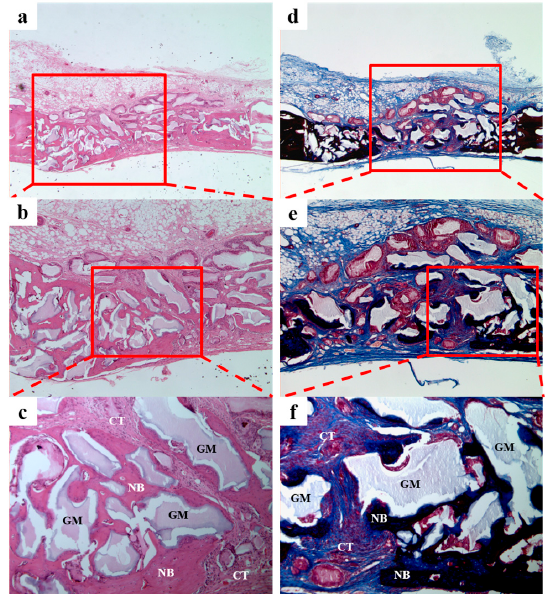
Figure 10. Histological sections of the BCP group at 4 weeks after surgery. A small amount of new bone formation and fibrous connective tissue were observed. NB: new bone; GM: grafted material; CT: connective tissue. Hematoxylin and eosin (H&E) stain results ( a – c ); and Masson’s trichrome staining results ( d – f ) (original magnifications: ×20 ( a , d ); ×40 ( b , e ); and ×100 ( c , f )).